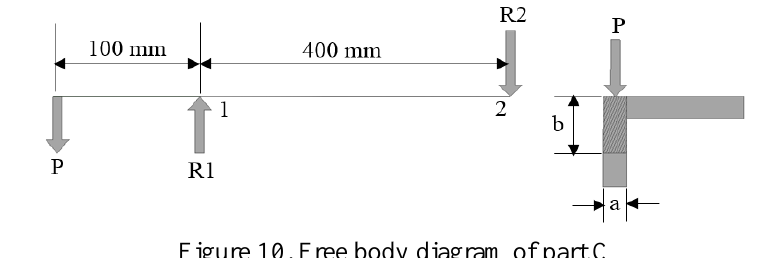
Figure 10. Free body diagram of part